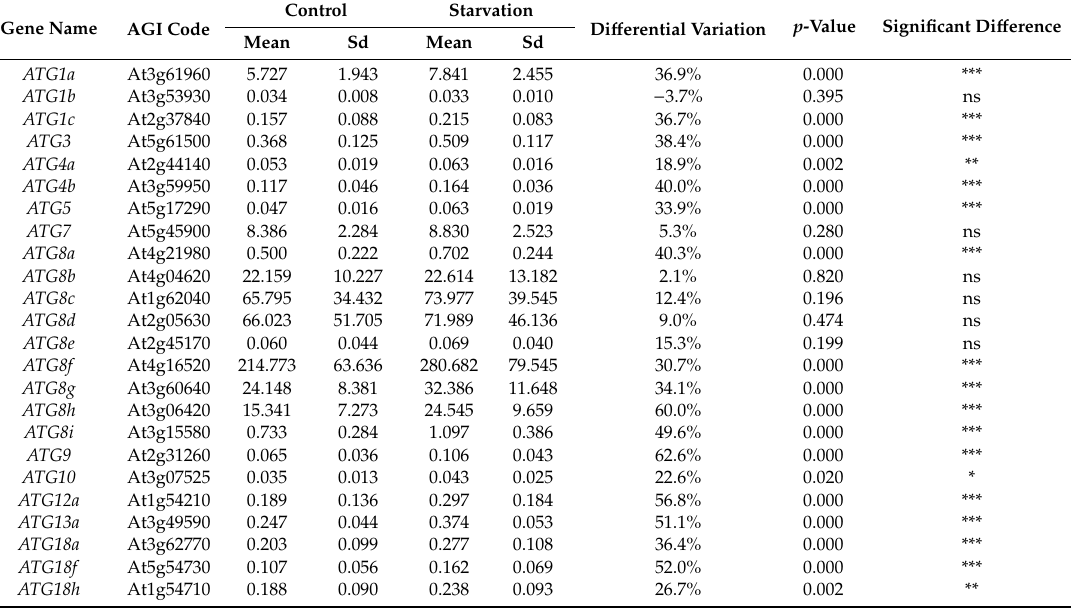
Table 2. Averages of di ff erential expression of ATG genes between the control and starvation